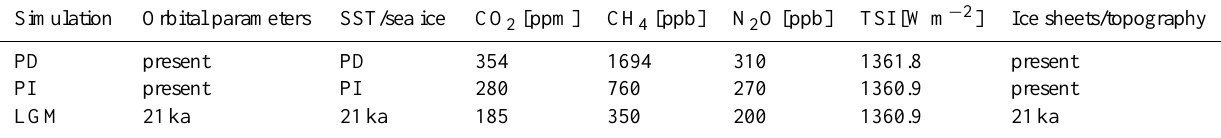
Table 2. List of CCSM4 simulations of preindustrial (PI) and Last Glacial Maximum (LGM) climates (Hofer et al., 2012; Merz et al., 2013) which are used as climate forcing in the ice model. Orbital parameters are calculated according to Berger (1978). Solar forcing is expressed as total solar irradiance (TSI). The LGM simulation uses the ICE-5G topography reconstruction (Peltier, 2004). All simulations have a time resolution of 1 day and a spatial resolution of 0 . 9 ◦ × 1 . 25 ◦ which is bilinearly interpolated to the ice model